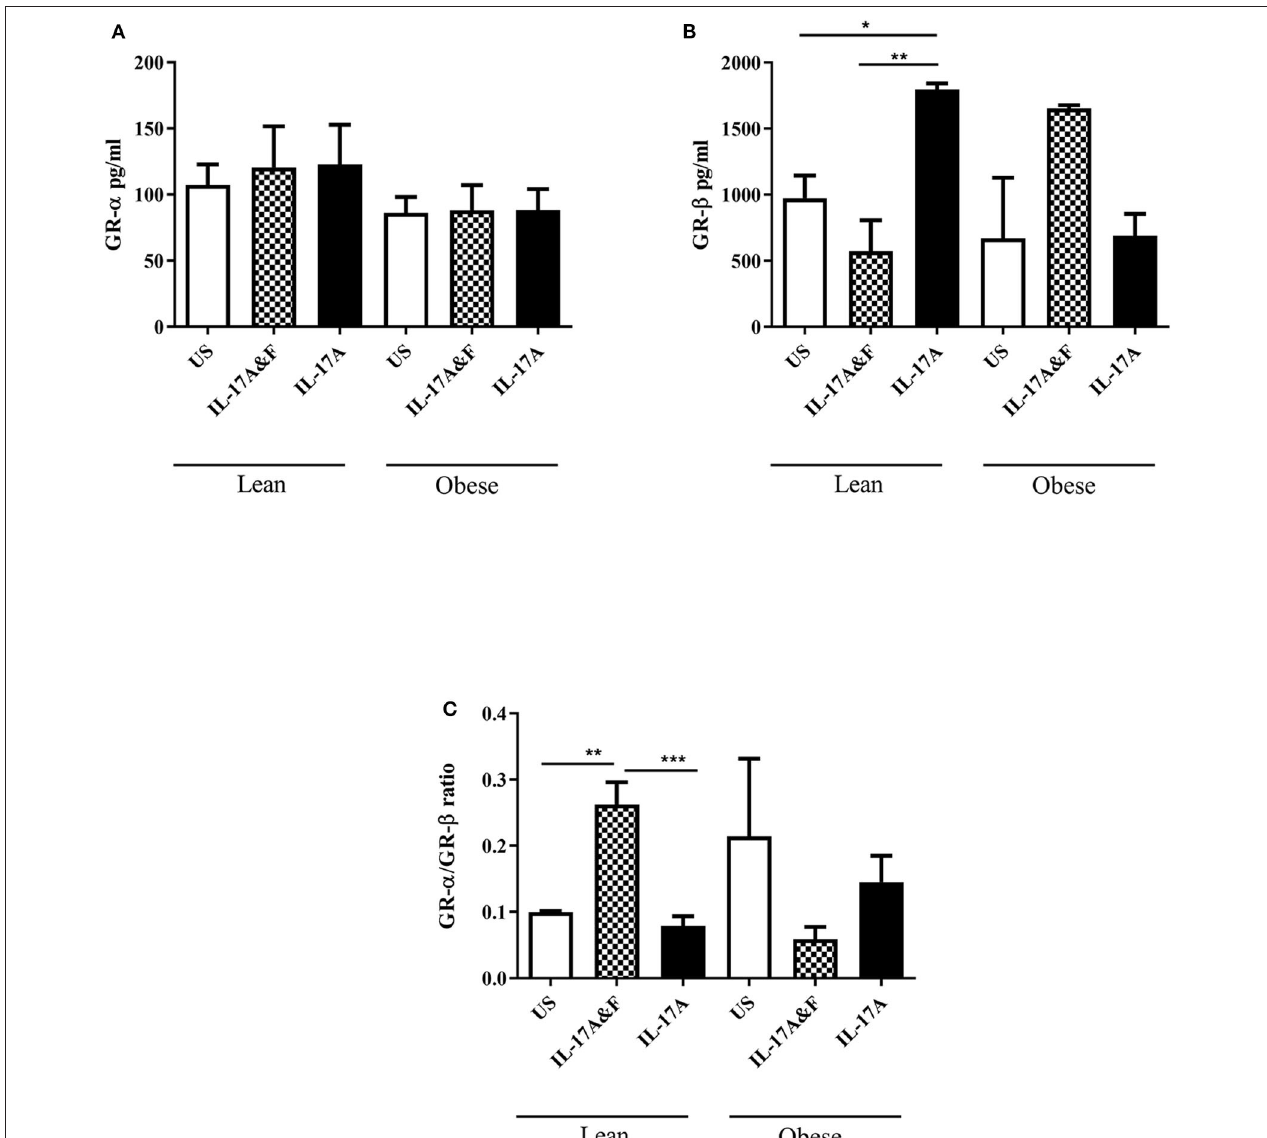
FIGURE 2 | IL-17A & F and IL-17A alone induces changes in protein levels of GR- β . GR- α (A) and GR- β (B) protein expression in adipocytes from lean and obese subjects following 48h stimulation with IL-17A&F combination or IL-17A alone (C) Ratio of GR- α /GR- β . n = 4 lean subjects, n = 3 obese subjects, One-way ANOVA, Mean ± SE; * P < 0.05, ** P < 0.01, *** P < 0.001. Data is representative of three